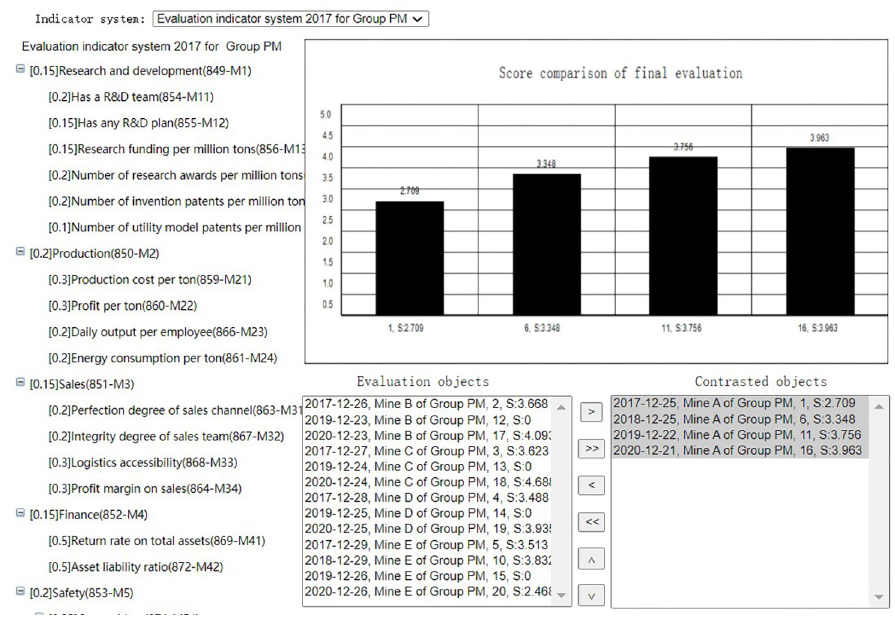
Fig 23. Longitudinal score